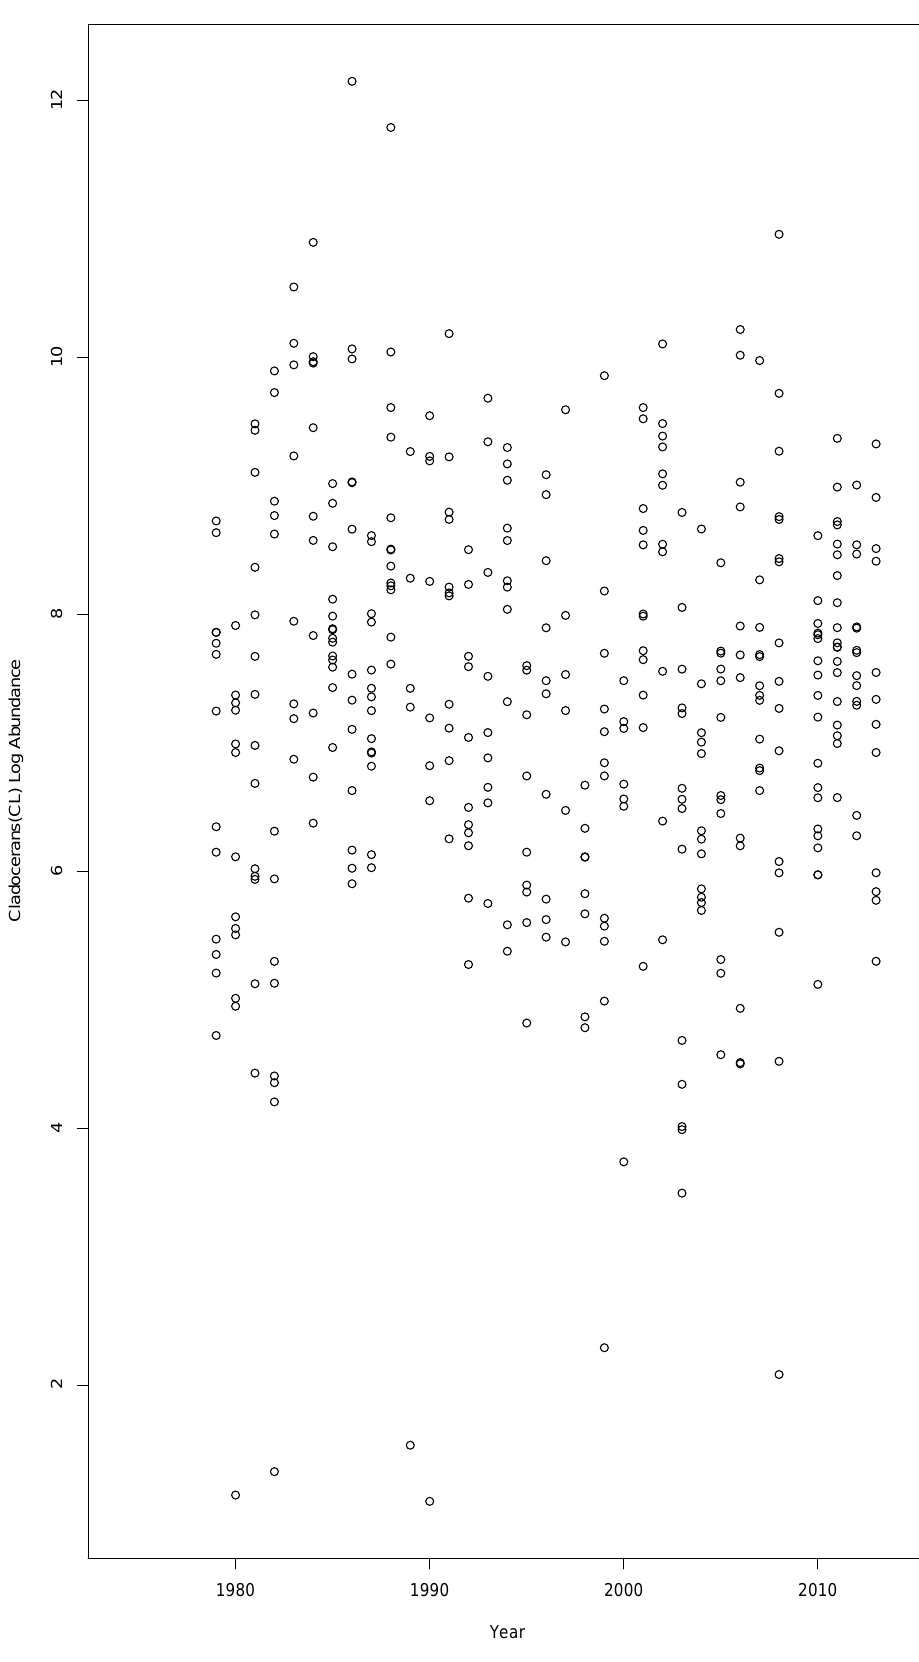
Figure 5. Graph of the cladoceran observations across the